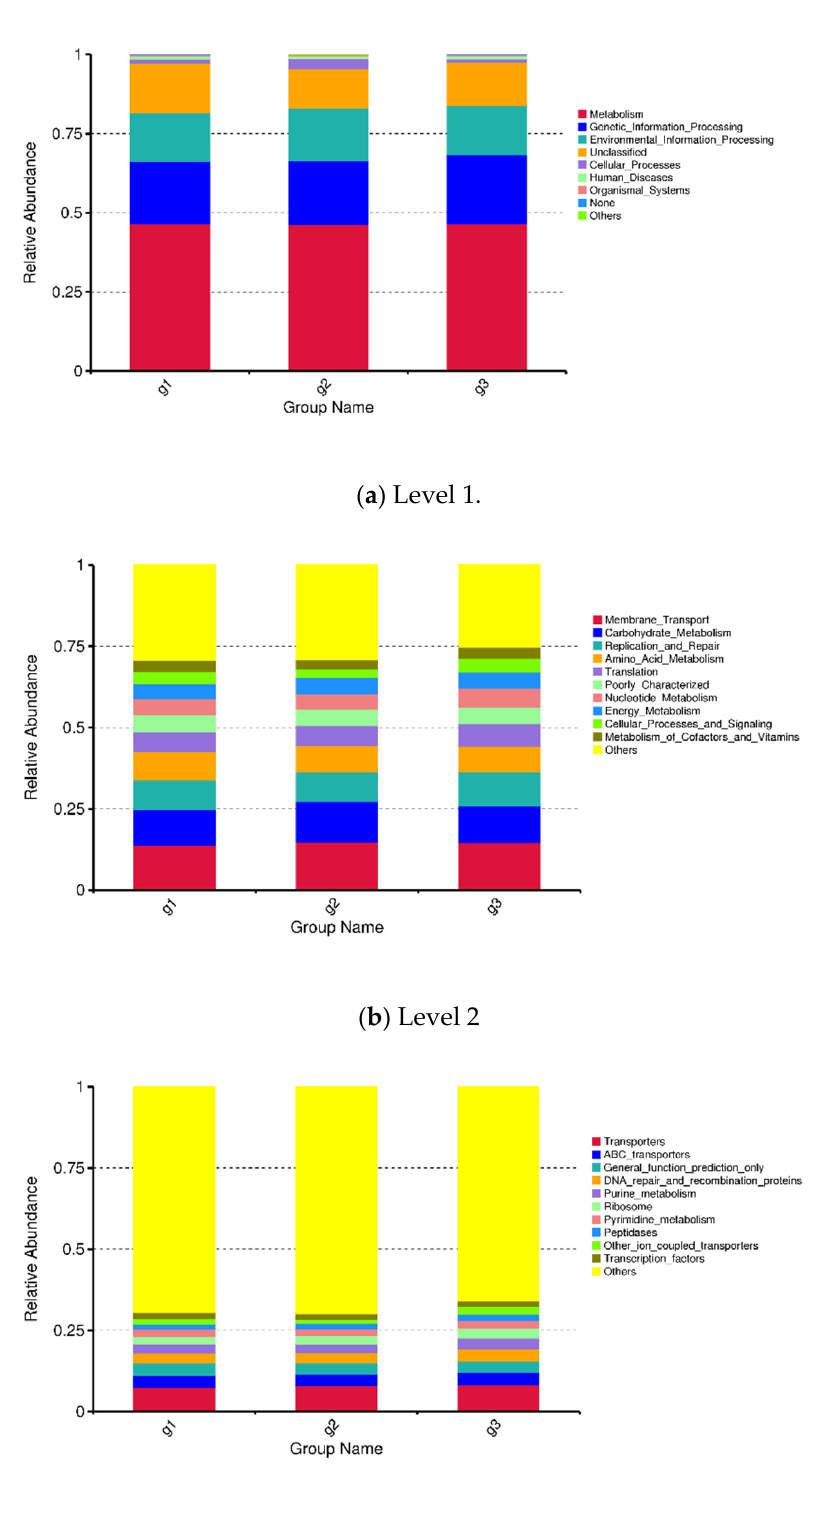
Figure 7. The principle metabolic pathway during PP fermentation according to functional orthologs from KEGG orthologies.